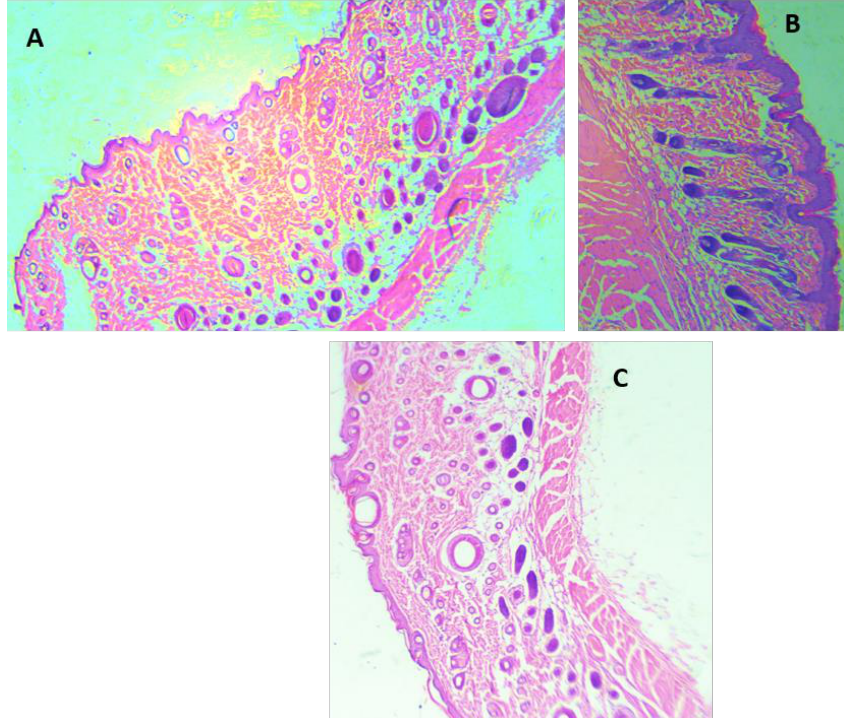
Figure 4. Histological analysis using hematoxylin and eosin staining of control ( A ), Artemisia Judaica ( B ), and SS ( C ). Arrows (black) indicate neutrophil infiltration; magnification 40×.